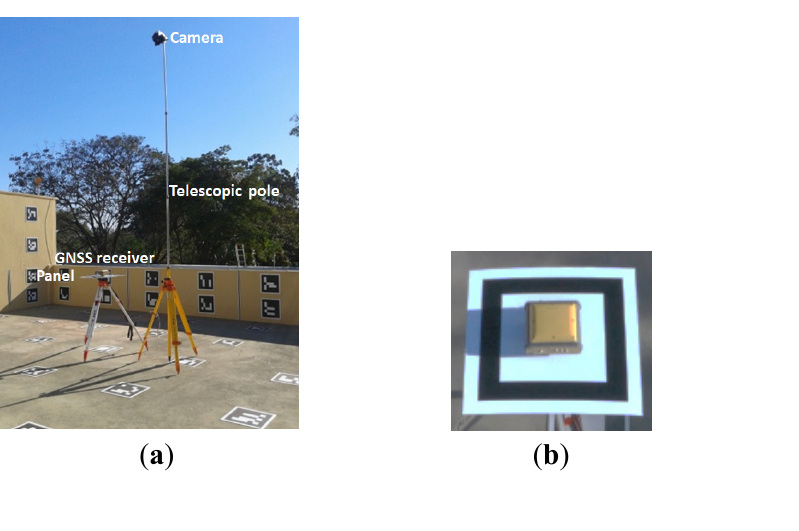
with the square